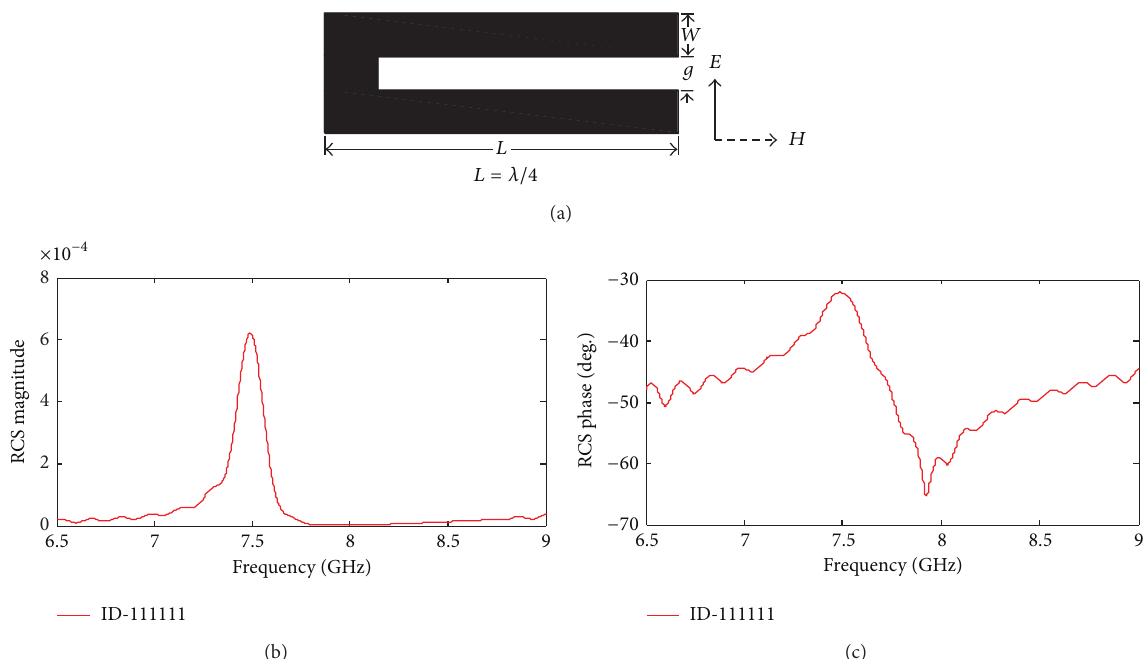
Figure 1: (a) Basic resonance element using slot resonator, the dimensions are 𝐿 = 8.5 mm, 𝑊 = 1.5 mm, and 𝑔 = 0.5 mm. (b) Magnitude versus frequency response of slot resonator. (c) Phase versus frequency response of slot